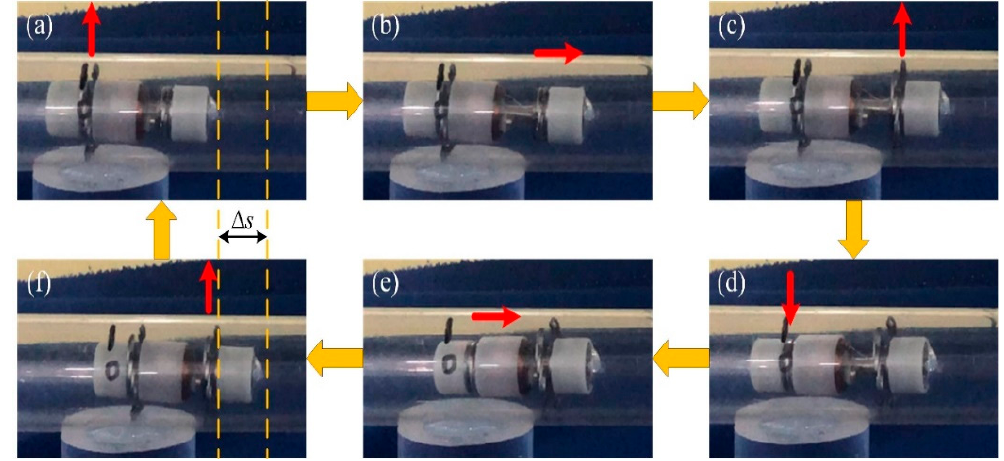
Figure 12. The movement experiment of the robot in a rigid pipe.